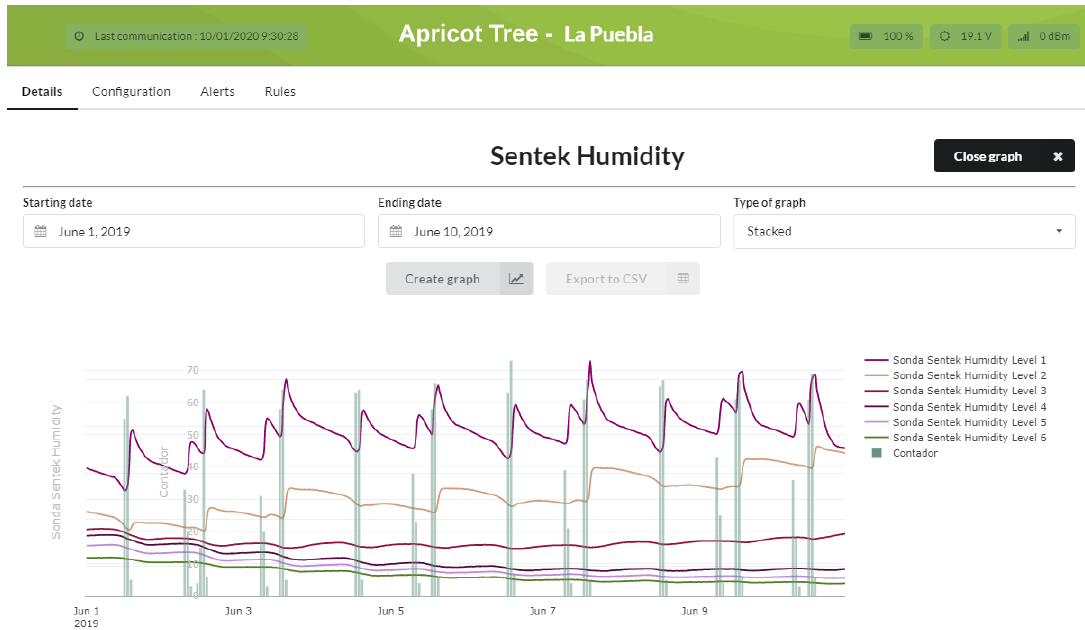
Figure 9. Evolution of efficient irrigation, comparing soil moisture and water contribution by the